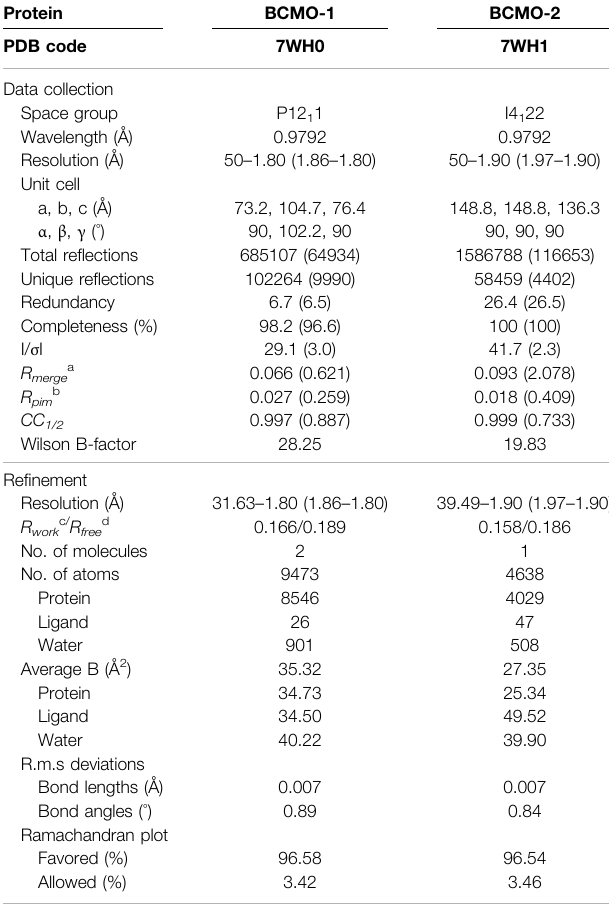
TABLE 1 | Data collection and re fi nement